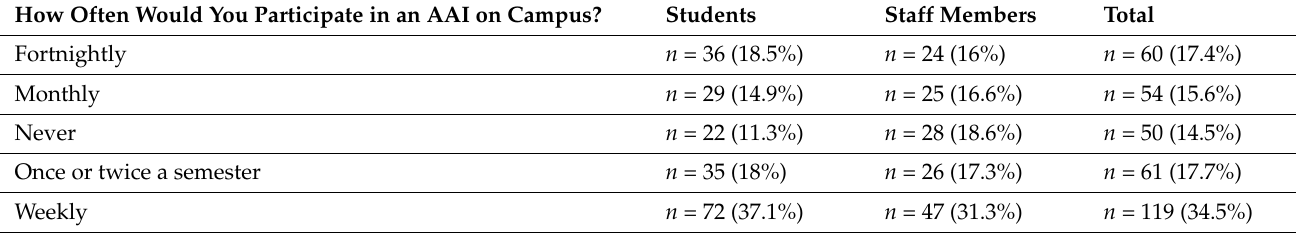
Table 3. preferred frequency survey